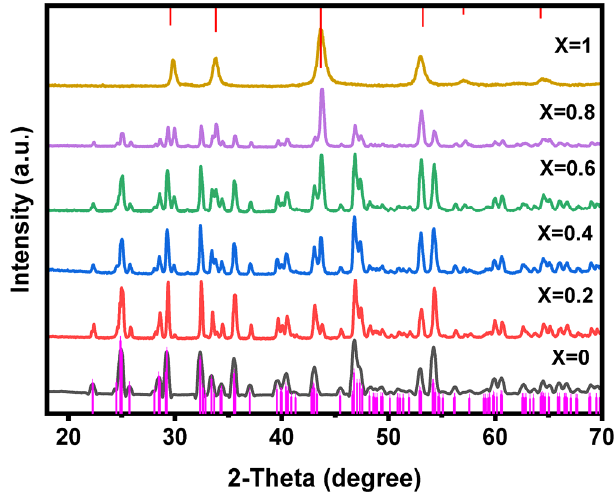
Figure 2. Powder X-ray diffraction (P-XRD) patterns of Sb 2(1 − x ) Fe 2 x S 3 (0 ≤ x ≥ 1) produced by solvent-less thermolysis at 450 °C with variation in Fe/(Fe + Sb) molar ratio x = 0, x = 0.2, x = 0.4, x = 0.6, x = 0.8, and x = 1 with a standard pattern of Sb 2 S 3 (bottom) and Fe 1.05 S 0.95 (top).